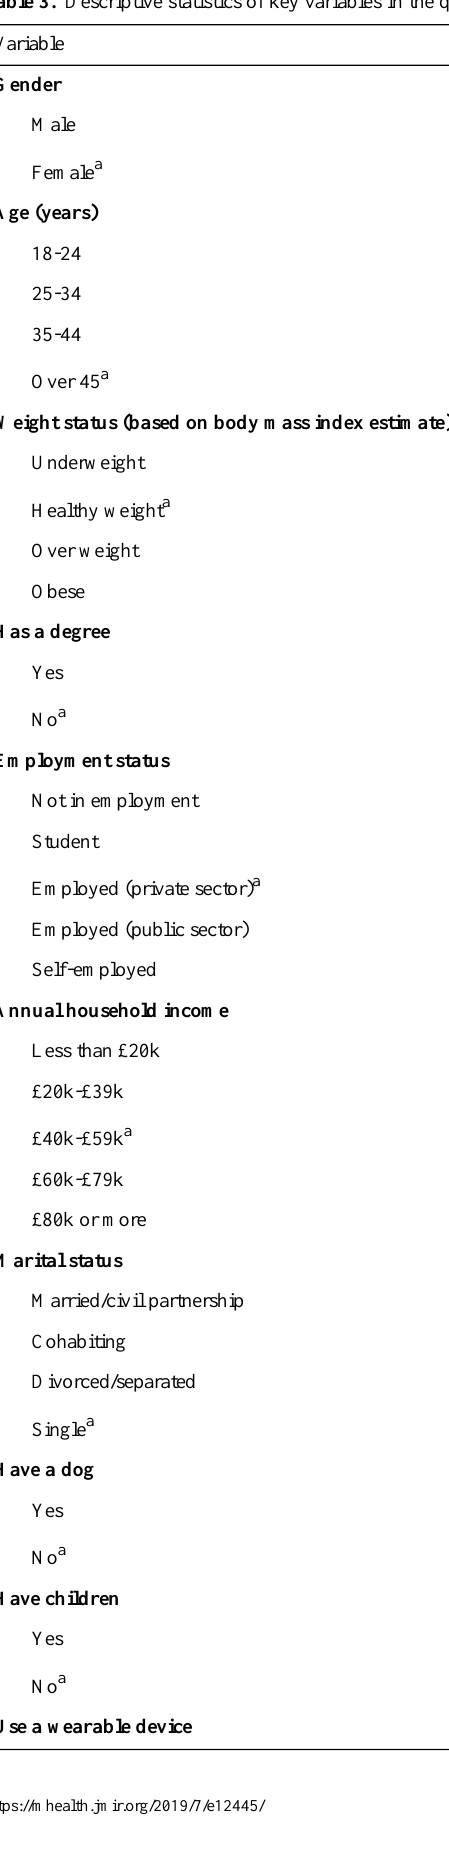
Table 3. Descriptive statistics of key variables in the questionnaire